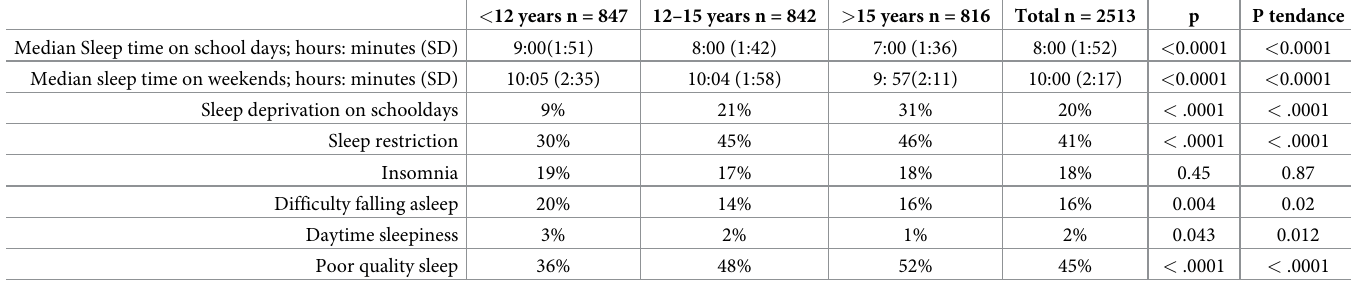
Table 1. Age, sleep time, sleep pathology, and daytime